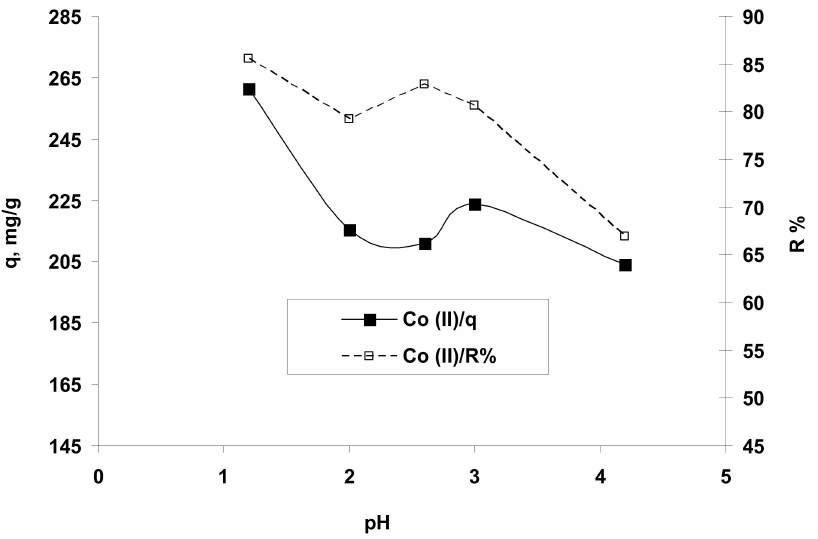
Figure 3. The influence of the solution pH on the retention of Co 2+ ions on hydrogel OxC25. Operational conditions: C 0 = 122.07 mg/L; 0.4 g/L biosorbent; T = 20 ◦